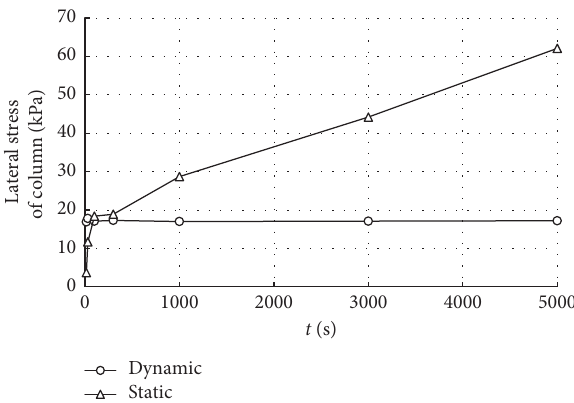
Figure 14: Lateral stress of the stone